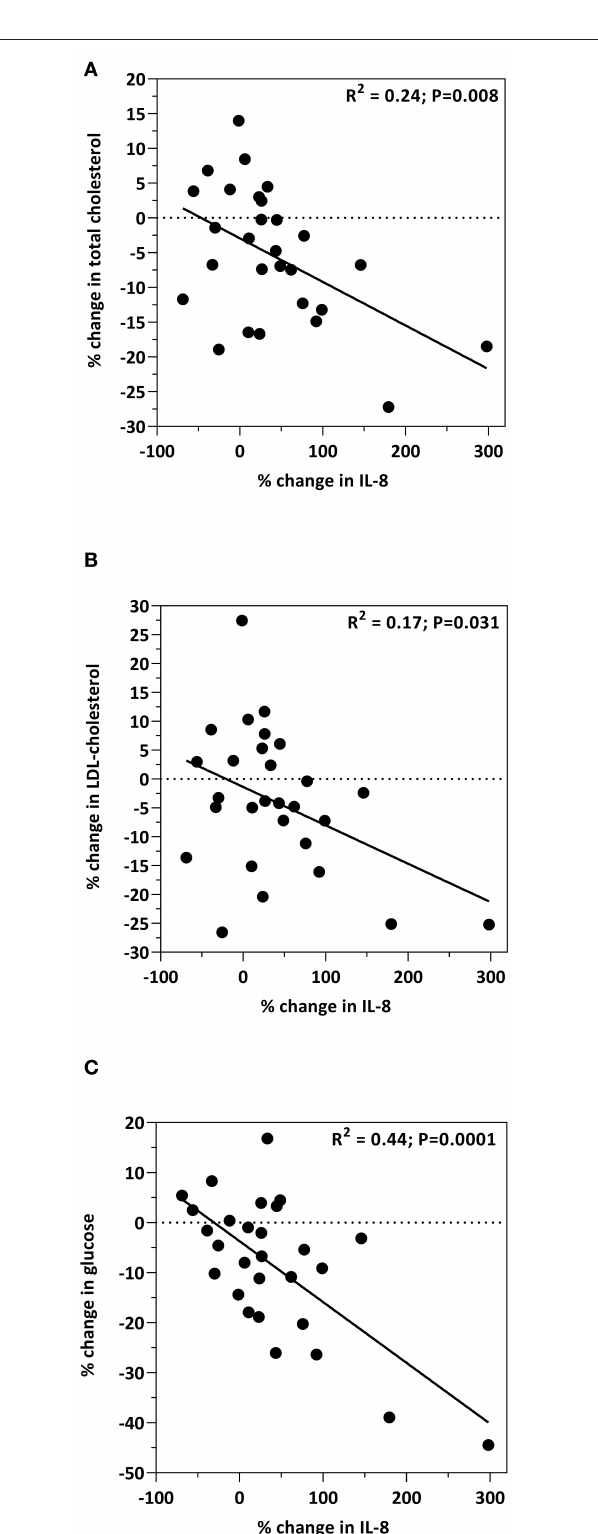
FIGURE 3 | Bivariate correlations between the percent change from baseline in IL-8 levels and the percent change from baseline in plasma total cholesterol (A) , LDL-C (B) and glucose (C)